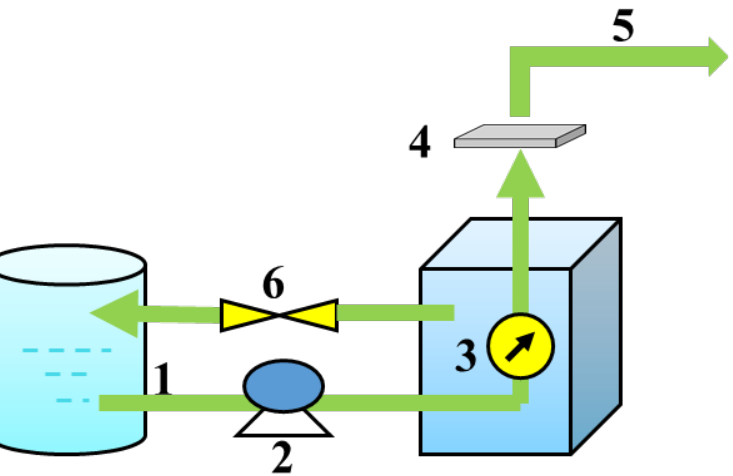
Figure 2. Membrane filtration system: (1) feed inlet; (2) pump; (3) pressure gauge; (4) membrane cell; (5) permeate end; (6) valve.